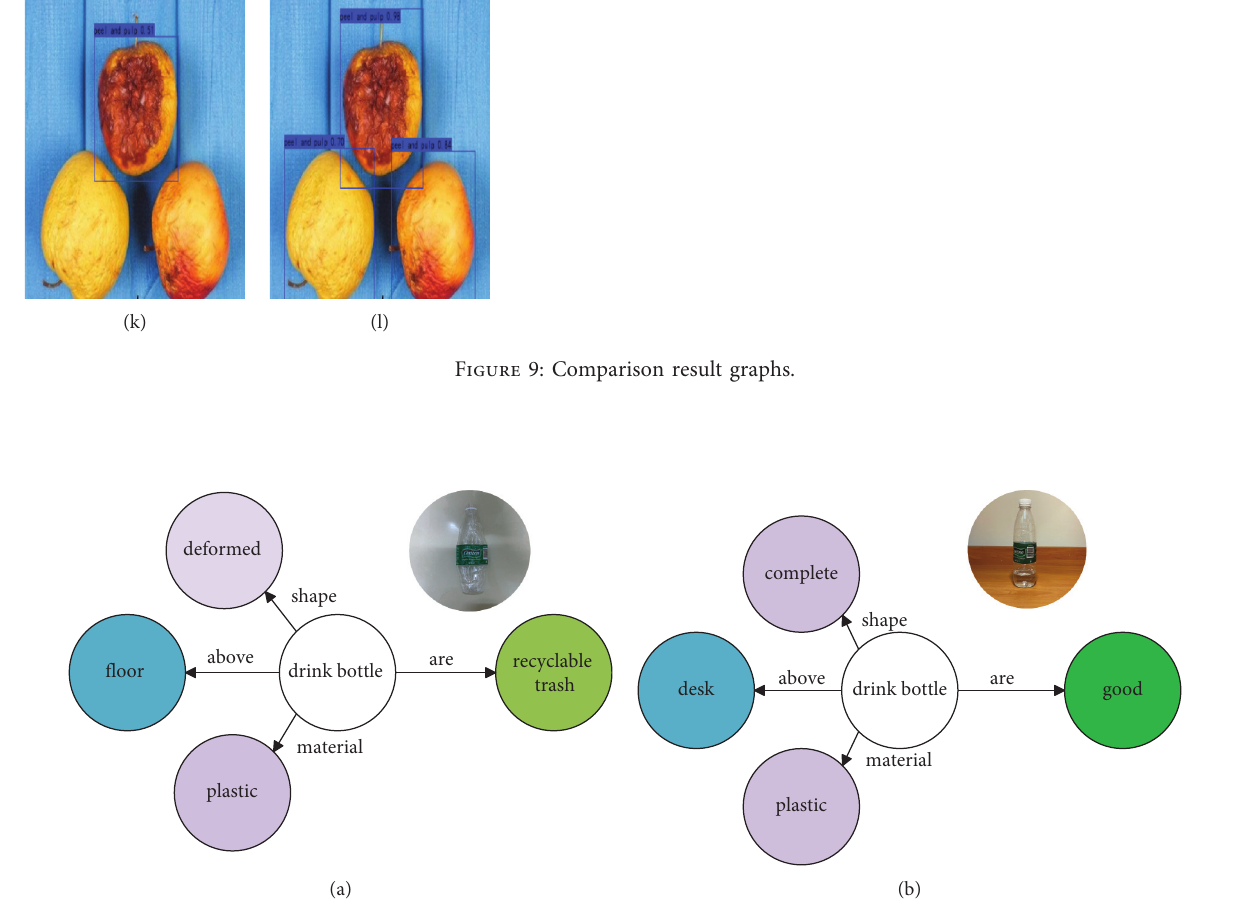
Figure 10: Garbage